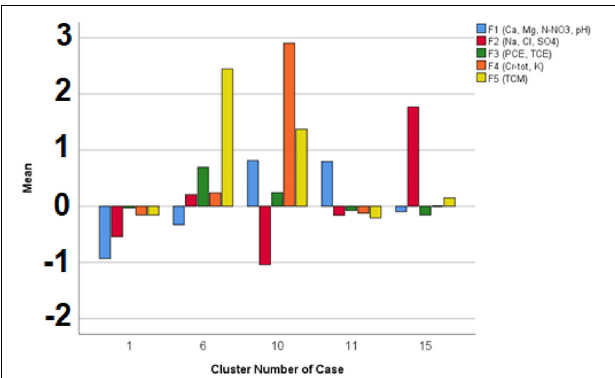
FIGURE 10 | Varifactor characteristics of the main clusters: bars show the mean varifactor values of the main clusters. The reference scale on the y axis is the one of the standardized variables, so 0 is the total sample average, and 1 is the total sample standard deviation.